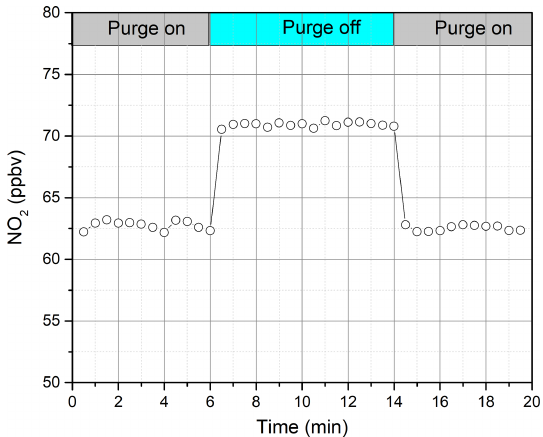
Figure 3. The change in the effective NO 2 concentrations during purge on and off. The effective cavity length is calculated according to the retrieved concentrations when purging is on and